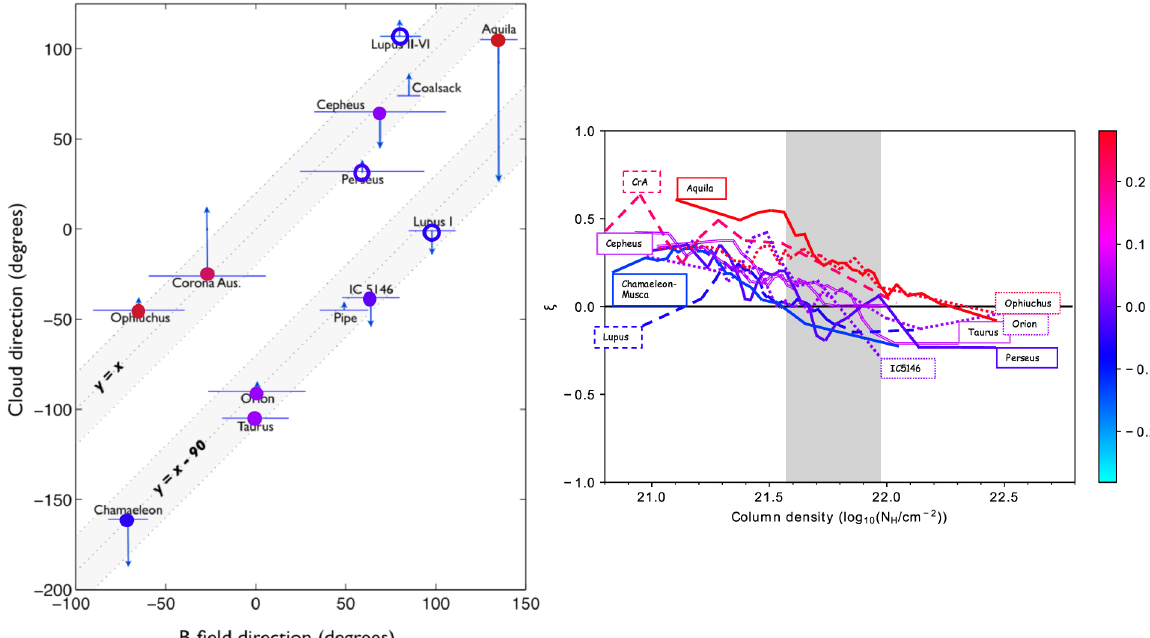
Figure 5. ( Left ): The bimodality of the global cloud-field alignment [15]. The horizontal bars show the interquartile ranges of the field directions (not the mean uncertainty), while the arrows show how the cloud orientation changes from low (end) to high (head) density. ( Right ): The pixel-by-pixel field-cloud structure alignment varies between parallel ( ξ = 1) and PE )/( PA + PE ), where PA ( PE) is the population within 22.5 ◦ perpendicular ( ξ = 1) [32]; ξ is defined by the ratio ( PA − − from parallelism (perpendicularity) [30]. The colour code is based on the averaged ξ value of each cloud within the “grey” density range, where the cloud column density PDFs deviate from log-normal and turn towards power-law. The grey range is the same as “zone C” in Figure 1 (lower-right), from Kainulainen et al. [16]. The colour of each cloud is also represented in the left panel. Generally speaking, the perpendicular clouds in the left panel have smaller ξ , which provides the connection between the two different alignment studies. Lupus and Perseus are hollowed, in the left panel, to suggest that they should be excluded from the comparison. Lupus was split into two subregions in [15], but not by [30]. Perseus shows evidence that optical and sub-mm polarimetry data emphasize very different regions